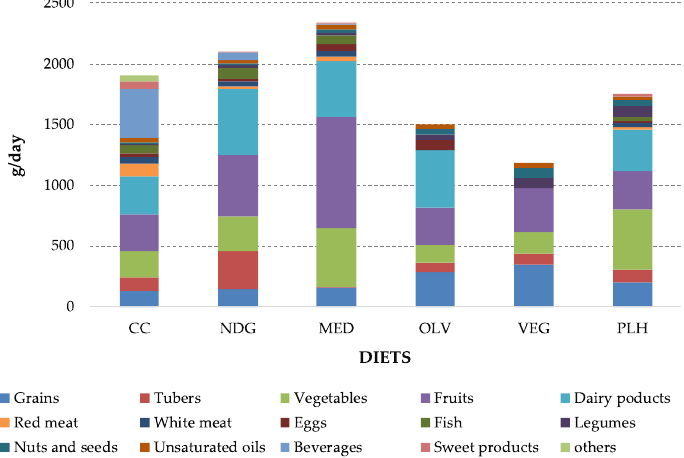
Figure 1. Daily gross food intake (g/day) of different food categories for all pre-defined diets.